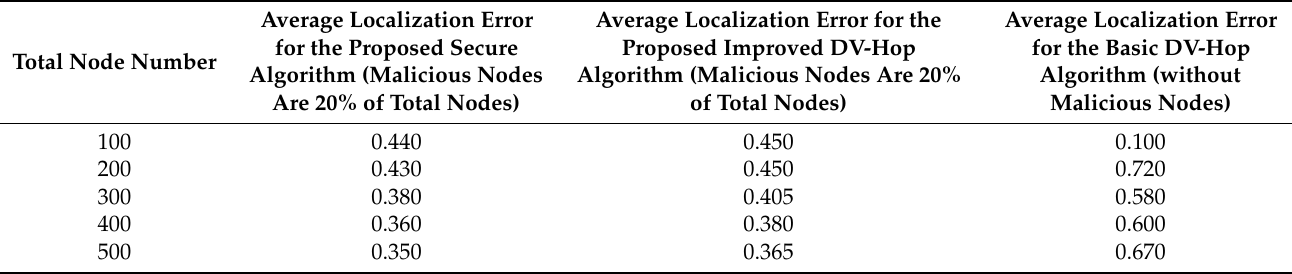
Figure 12. Variation of error by node number. Table 9. Average localization error variation corresponding to the total node number with and without malicious nodes for the proposed algorithm and other variants.